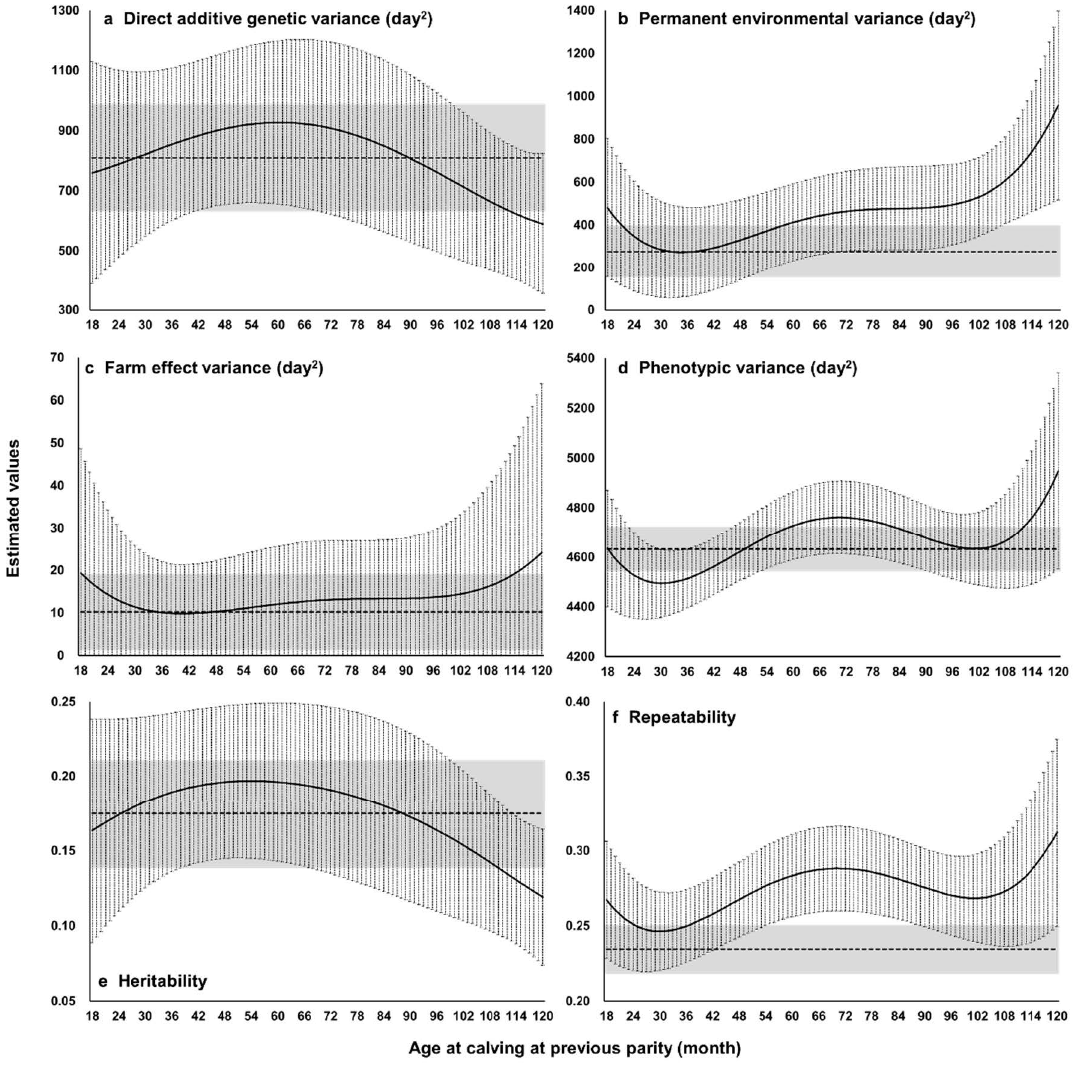
Figure 2. Estimated ( a ) direct additive genetic variance, ( b ) permanent environmental variance, ( c ) farm effect variance, ( d ) phenotypic variance, ( e ) heritability, and ( f ) repeatability. Curves and shading show the estimated values ± 3 standard errors: black solid with error bars, random regression model analysis; broken lines with grey area, repeatability model analysis.